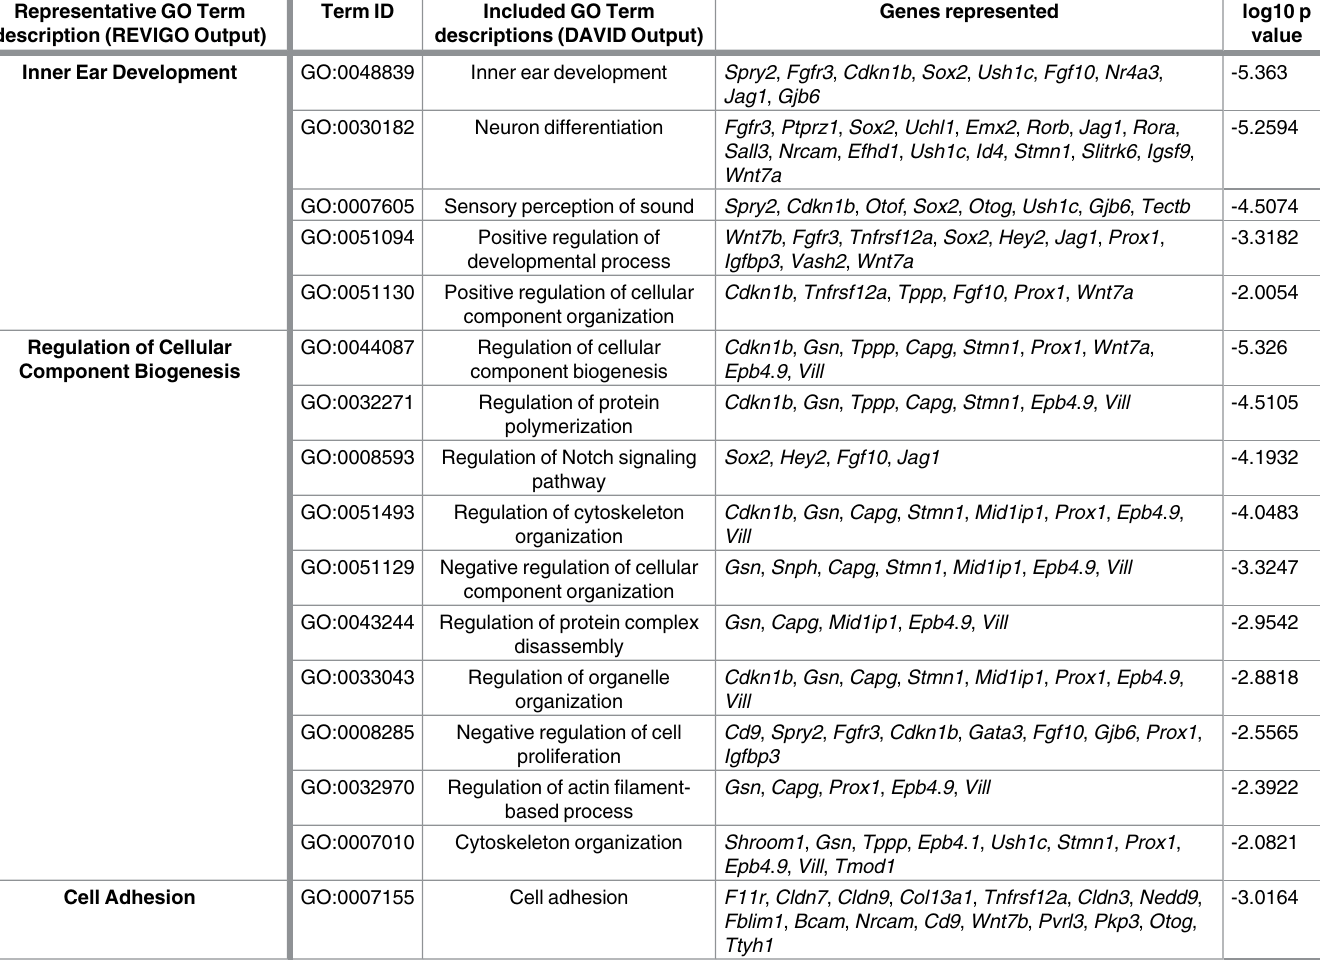
Table 6. Biological processes(BP) GO terms represented in the genes enriched in P6 Lfng-GFP + cells.